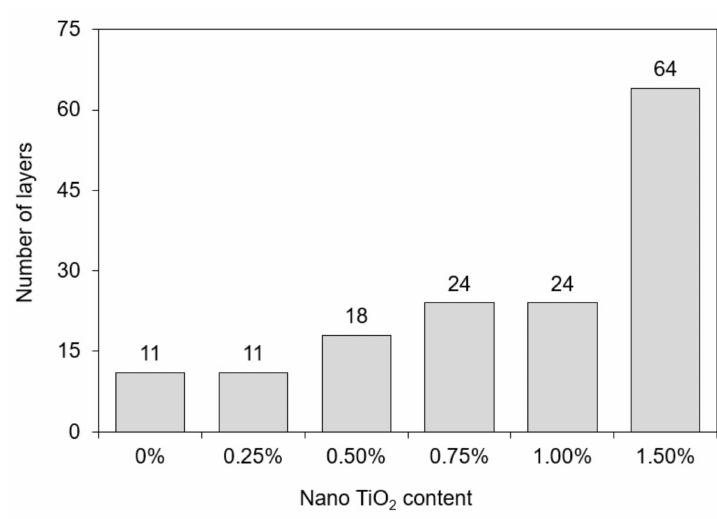
Figure 6. Failure during the buildability test for the different nano-TiO 2 contents. The arrows indicate the failure; (*) indicates that the failure occurred in the opposite face.